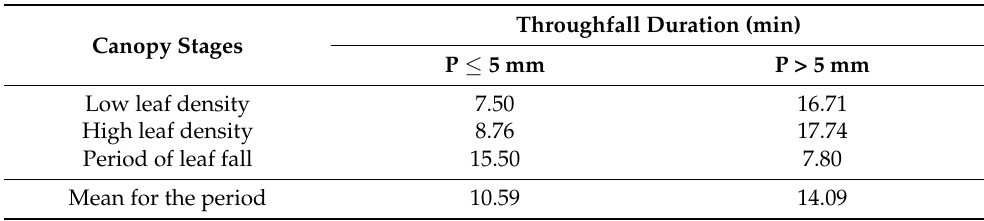
Figure 5. Relationship between gross rainfall (P) and throughfall (TF) in the three stages of canopy development: (Figures a , b ) on the top means P ≤ 5.0 mm and (Figures c , d ) on the bottom means P > 5.0 mm. * The colors in the figures indicate the different stages of canopy development. * Different letters (a, b) represent a statistically different median at the level of 1% by the Wilcoxon test. Table 4. Mean throughfall duration after a rainfall event has